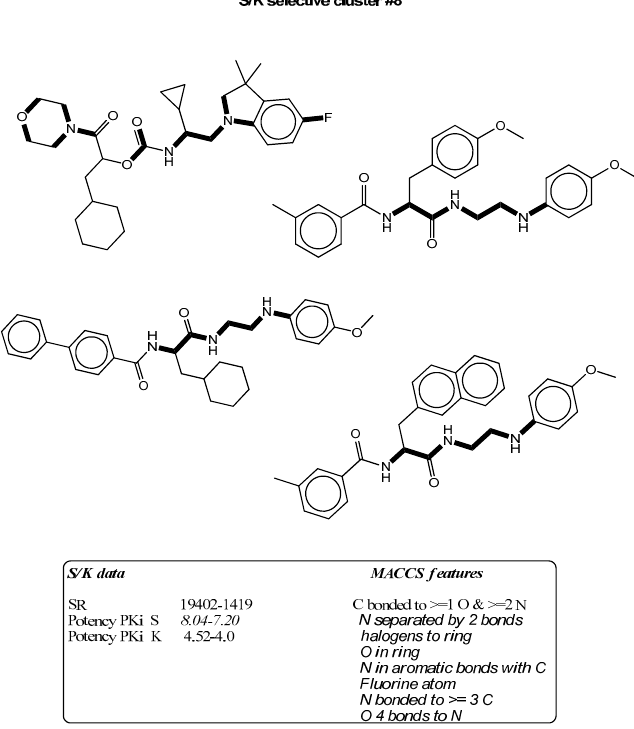
Figure 6. The figure shows mapping of representative MACCS selectivity signatures with high occurrence to S/K selectives presented by bold black highlighting. Table 2. Overall SOM performance against all cathepsins inhibitors.